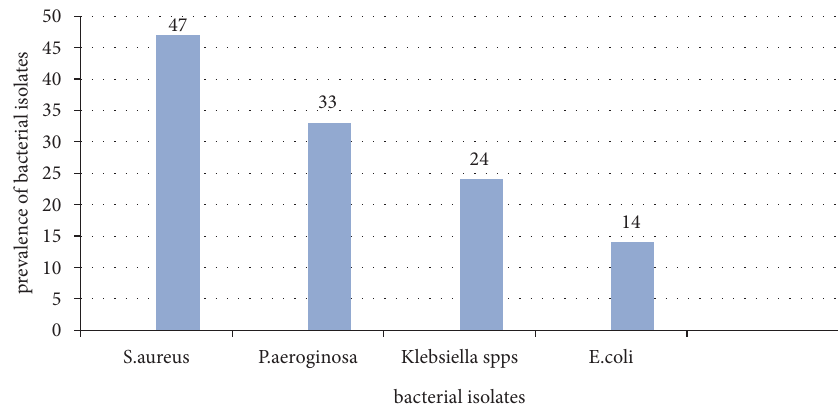
Figure 2: Distribution of air-borne and surface-borne bacterial isolates at WSUCH, Wolaita Sodo, Ethiopia, 2021. Table 1: Frequency of bacterial isolates from surface of ICU at WSUCH, Wolaita Sodo Ethiopia, 2021. Source of specimens